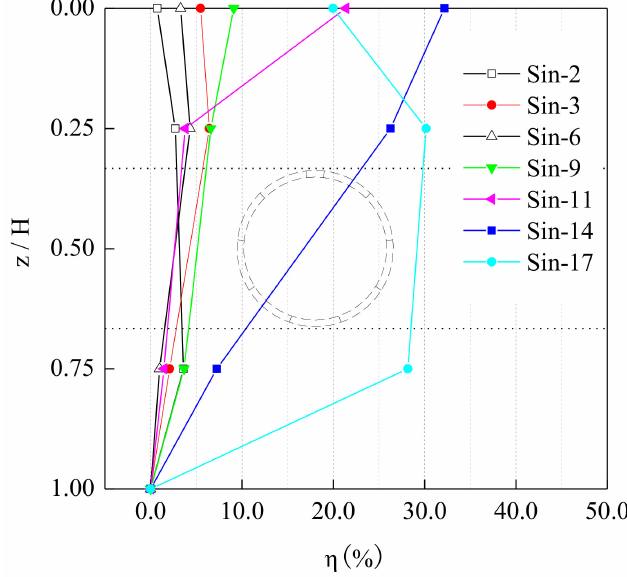
Figure 18. Difference between FF model and ST